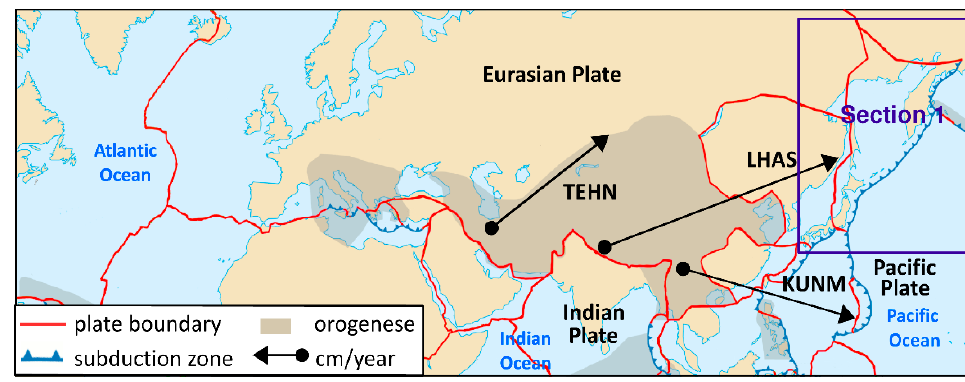
Figure 2. The location and motion of the GNSS stations that are not consistent with the Eurasian plate motion.